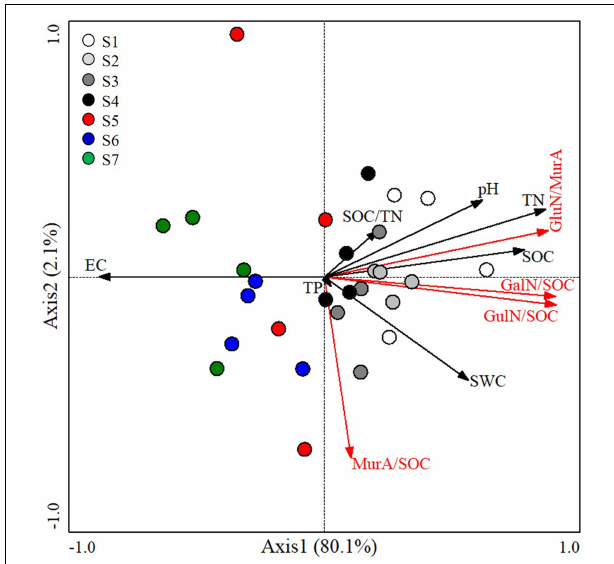
FIGURE 5 | Redundancy analysis detecting the relationships of AS parameters with soil physicochemical properties along a salinity gradient (white circle, S1; light gray circle, S2; gray circle, S3; black circle, S4; red circle, S5; blue circle, S6; green circle, S7). Black vectors indicate trajectories of soil chemical parameters as independent variables; red vectors indicate AS parameters, including the ratio of GluN, GalN, and MurA to SOC and GluN/MurA. The acute and obtuse angles among variables represent positive and negative relationships, respectively. The numbers in brackets indicate the percentage of the total variance explained by the first and second axes. Soil physicochemical properties with significant effects on AS parameters are evaluated at the 0.05 level (Monte Carlo tests with 499 permutations).